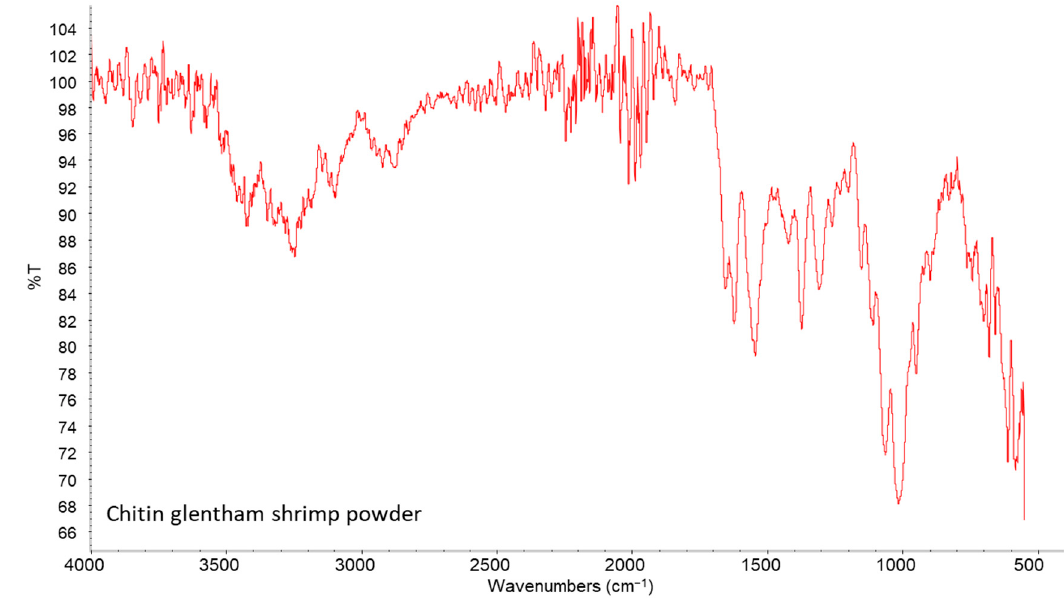
Figure 1. ATR-IR spectrum of shrimp chitin powder.